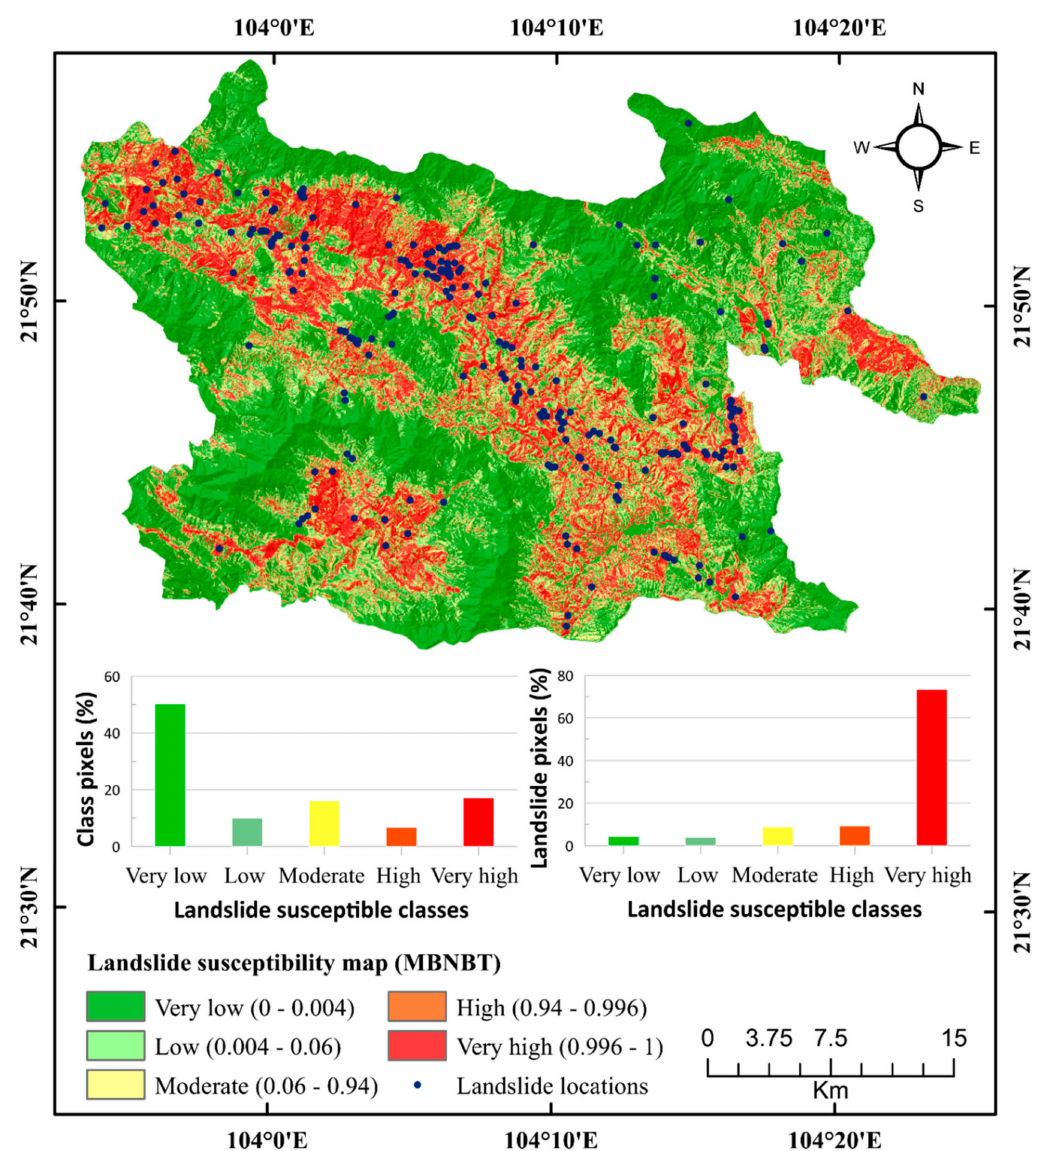
Figure 6. Landslide Susceptibility Map (LSM) of the study area based on the MBNBT